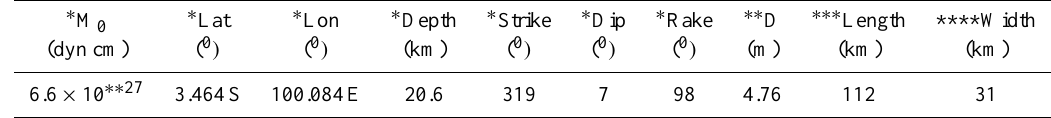
Table 5. Epicentral location of earthquake, earthquake parameters and GCMT solution used in this study. ∗ M ∗ Lat ∗ Lon ∗ Depth ∗ Strike ∗ Dip ∗ Rake ∗∗ D ∗∗∗ Length ****Width 0 (dyn cm) ( 0 ) ( 0 ) (km) ( 0 ) ( 0 ) ( 0 ) (m) (km)